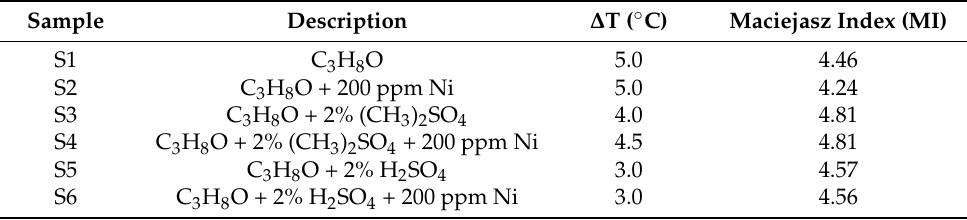
Table 5. Global results samples